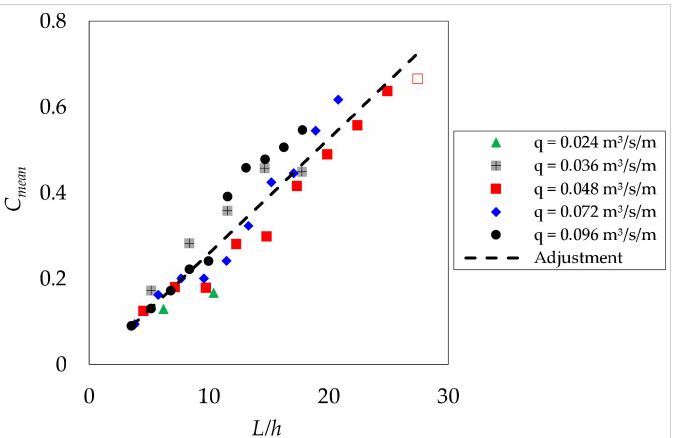
Figure 6. Mean void fraction as a function of dimensionless falling distance L/h (filled marker: case L ≤ L b ; unfilled marker: case L > L b ).